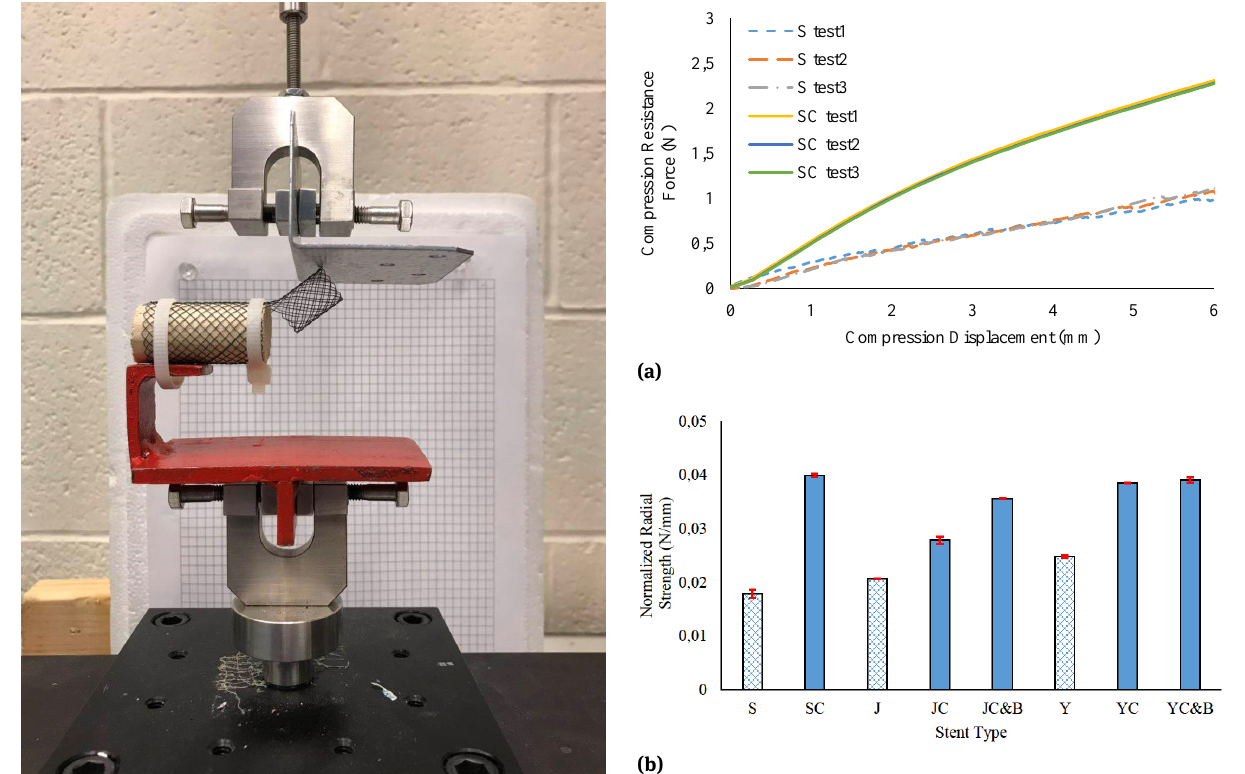
Figure 4: (a) Representative compression behavior, and (b) Normal- ized radial strength of the